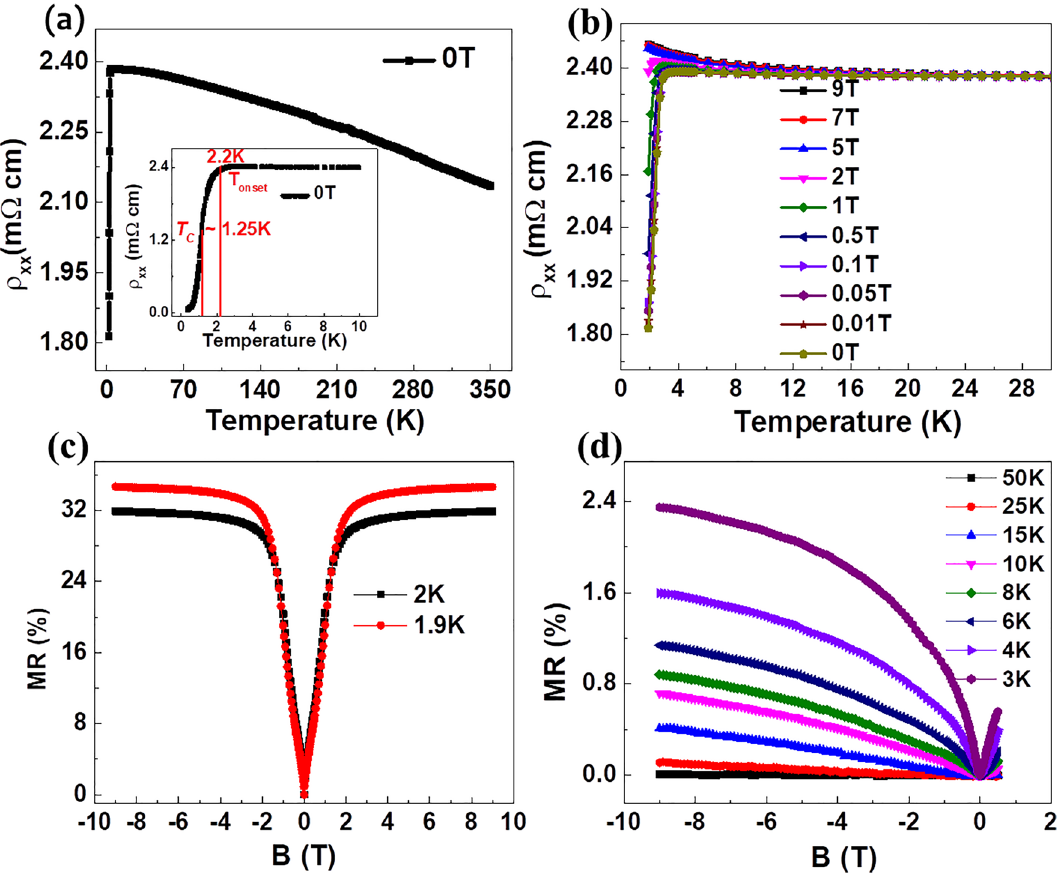
Figure 2. Electrical and magneto-transport properties of YPdBi: ( a ) The ρ xx as a function of temperature in range 1.9 K ≤ T ≤ 350 K , inset shows ρ xx measured from 0.38 to 10 K. ( b ) The ρ xx vs temperature measured in presence of magnetic field from 0 to 9 T in temperature range 1.9–50 K. ( c ) MR data at temperatures 1.9 K and 2 K. ( d ) MR data in the temperature range 3 K ≤ T ≤ 50